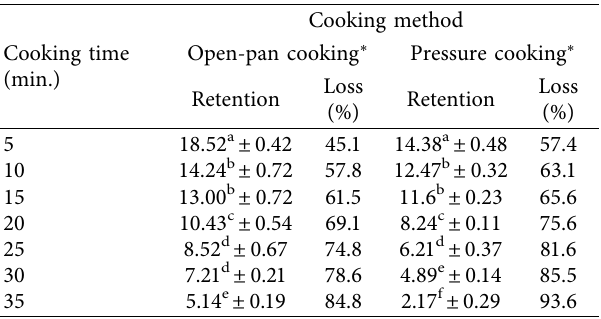
Table 1: Retention (mg/100g) and percent loss of ascorbic acid in cabbage under each cooking method.